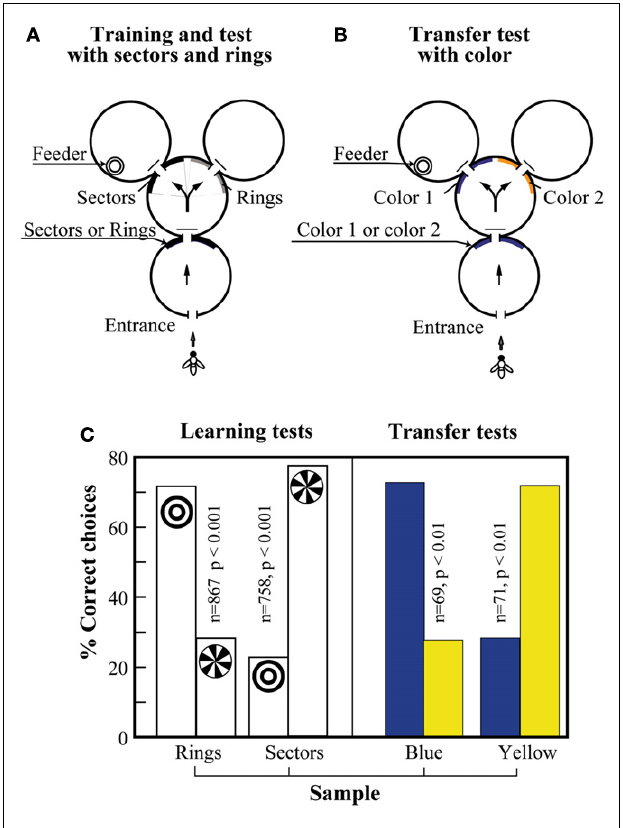
FIGURE 11 | Learning the concept of “sameness” in the visual modality. (A) Maze setup with geometric patterns as sample and matching stimuli. (B) Maze setup with colors as sample and matching stimuli. (C) After learning geometric pattern matching (left panel), the bees were immediately able to solve the color matching task as well (right panel). Modified from Giurfa et al. (2001). Details in text.